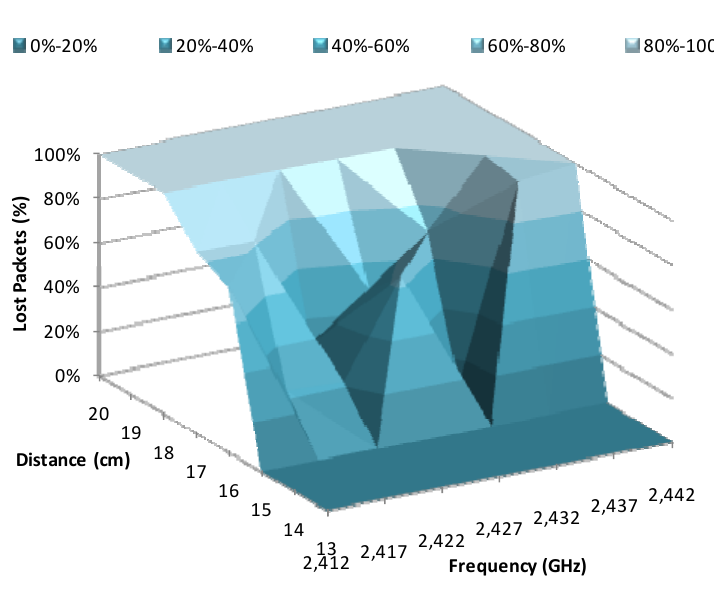
Figure 9. Lost packets for 2 Mbps.